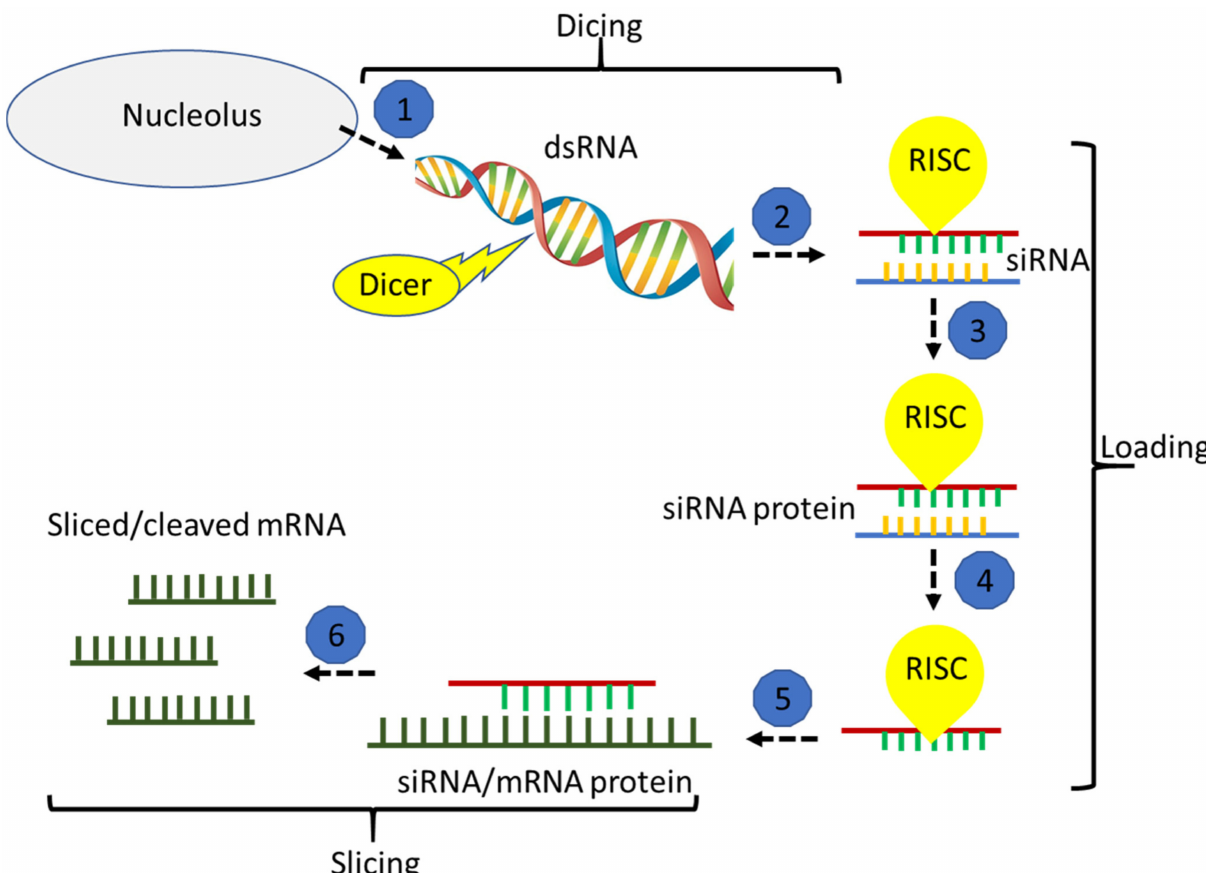
Figure 1. Illustration of the general RNAi pathway overview. Steps (1, 2) refer to dicing, (3, 4 and 5) refer to loading, (6) refer to slicing. (Adapted from